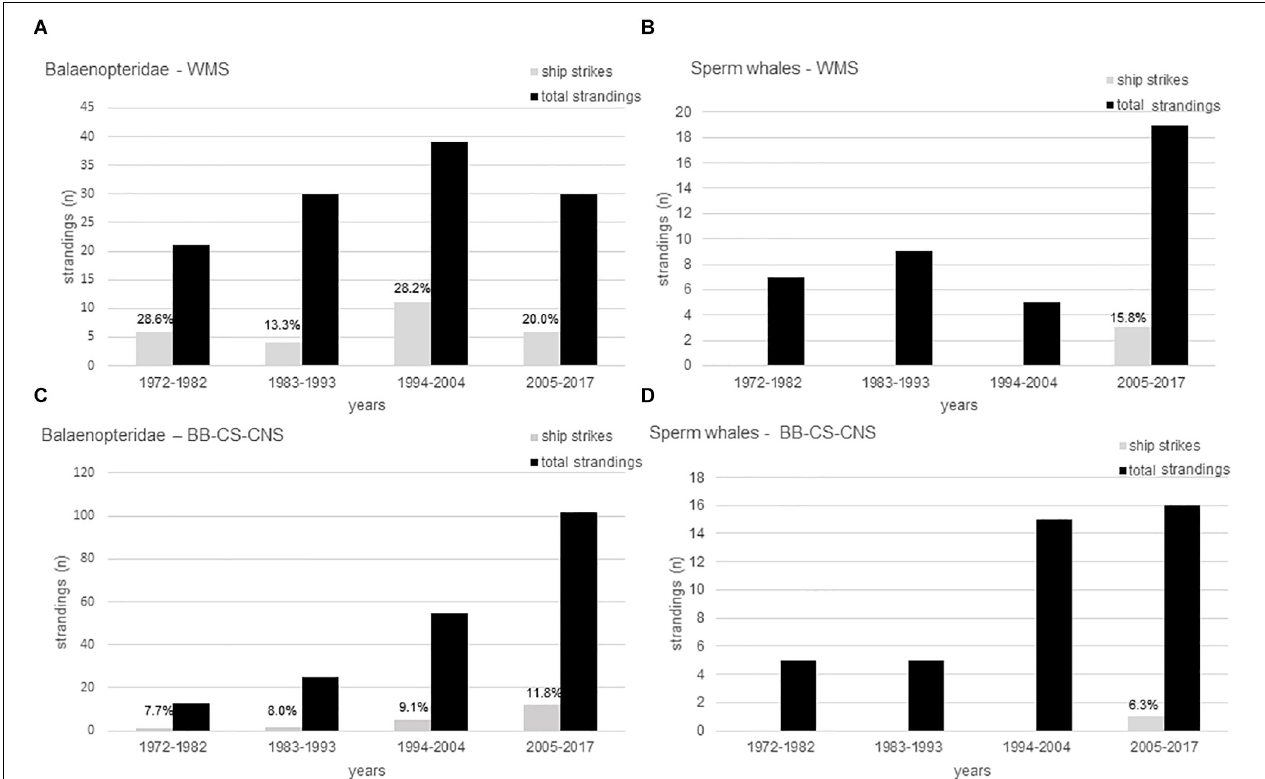
FIGURE 1 | The number of strandings with evidence of a lethal ship strike (gray bars) and the total number of strandings (black bars) per decade interval for balaenopterids (A,C) fin whales, minke whales, humpback whales, and undefined baleen whales) and sperm whales (B,D) along the Western Mediterranean Sea (WMS) and Bay of Biscay (BB), Celtic Sea (CS) and Channel-North Sea (CNS) coasts of France. The percentage of stranded carcasses with evidence of ship strike as a proportion of all strandings are